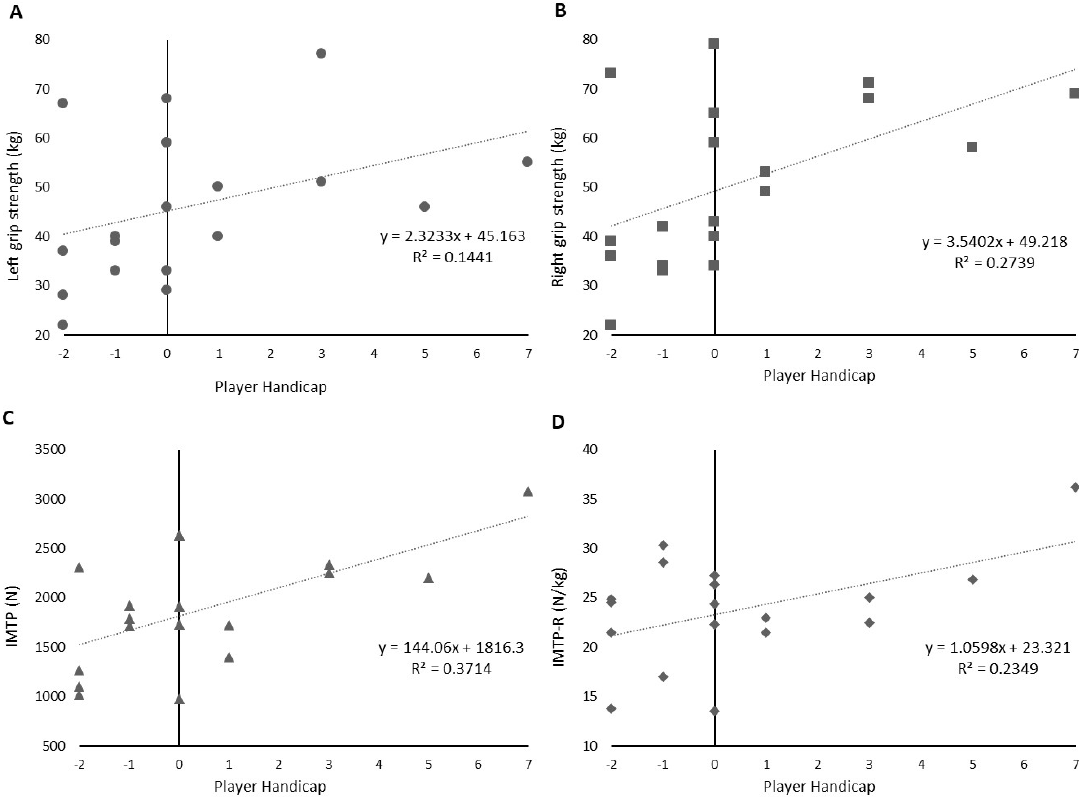
Figure 1. Individual data points and accompanying linear regression lines for left ( A ) and right ( B ) hand grip strength, IMTP ( C ) and IMTP-R ( D ).